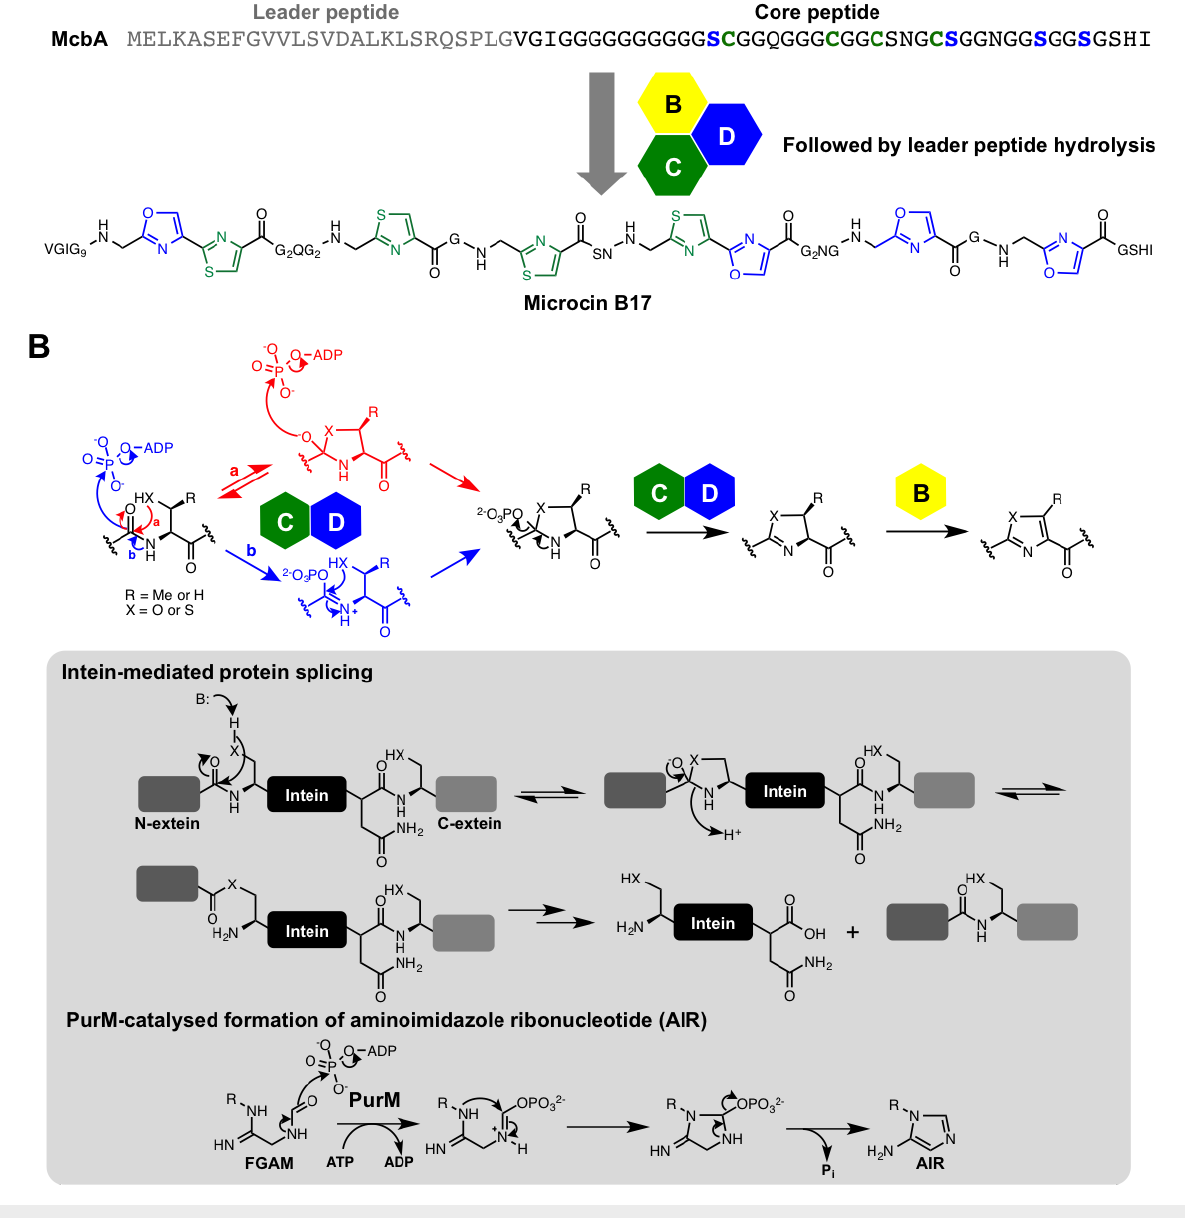
Figure 3: Formation of thiazoles and oxazoles in RiPPs. A) Biosynthesis of microcin B17. B) Mechanistic models for the introduction of azol(in)es into microcin, where pathway a was reported by the authors as the likely order of steps. An analogous mechanism was proposed in the biosynthesis of trunkamide, but with the transfer of AMP instead of phosphate. Inset: partial mechanism of intein-mediated protein splicing, which proceeds via a re- versible hemiorthoamide, and the proposed mechanism of PurM-catalysed conversion of formylglycinamide ribonucleotide (FGAM) into aminoimida- zole ribonucleotide (AIR), which involves activation of an amide by ATP and a 5- endo -trig cyclisation.